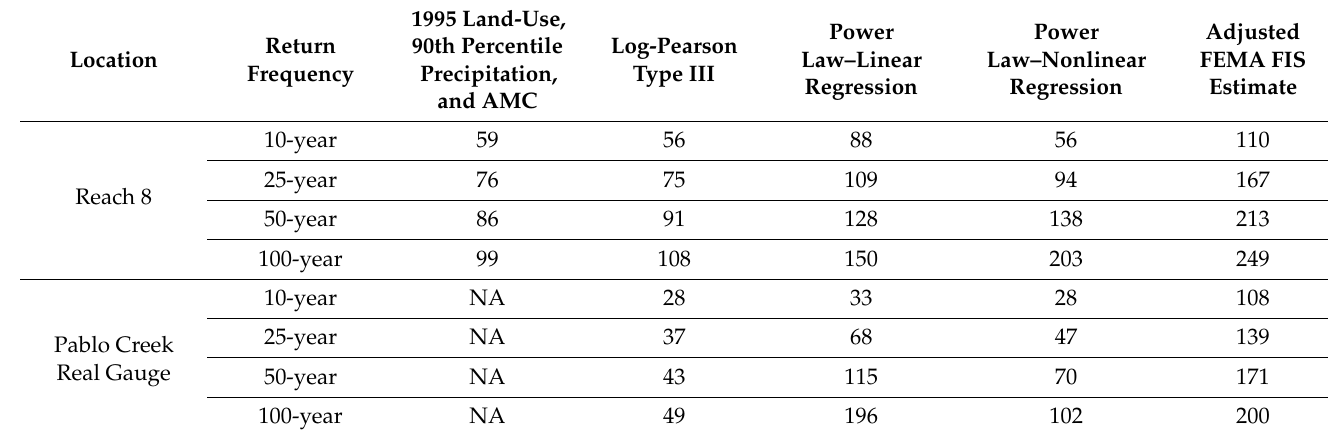
Table 1. Comparison of estimates at Pablo Creek (in m 3